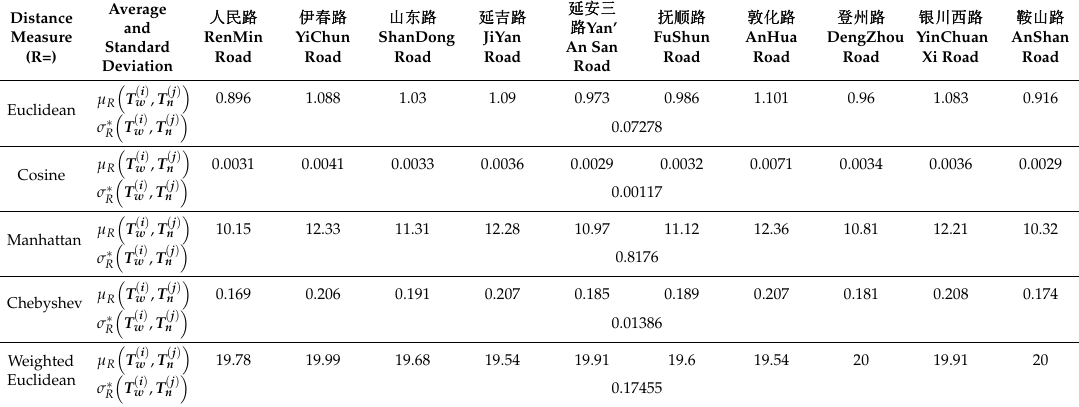
Table 5. Average and standard deviation of topic distances for different